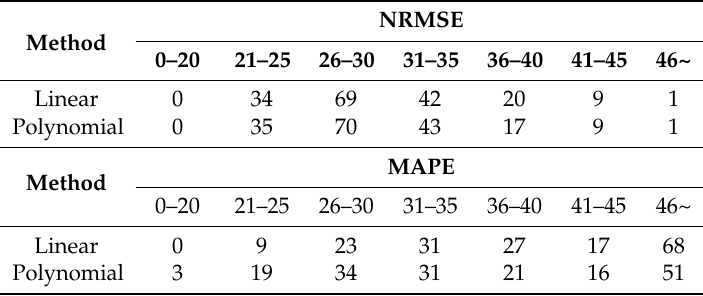
Table 2. The distributions of estimation errors of stations for the cases of linear and non-linear regression.